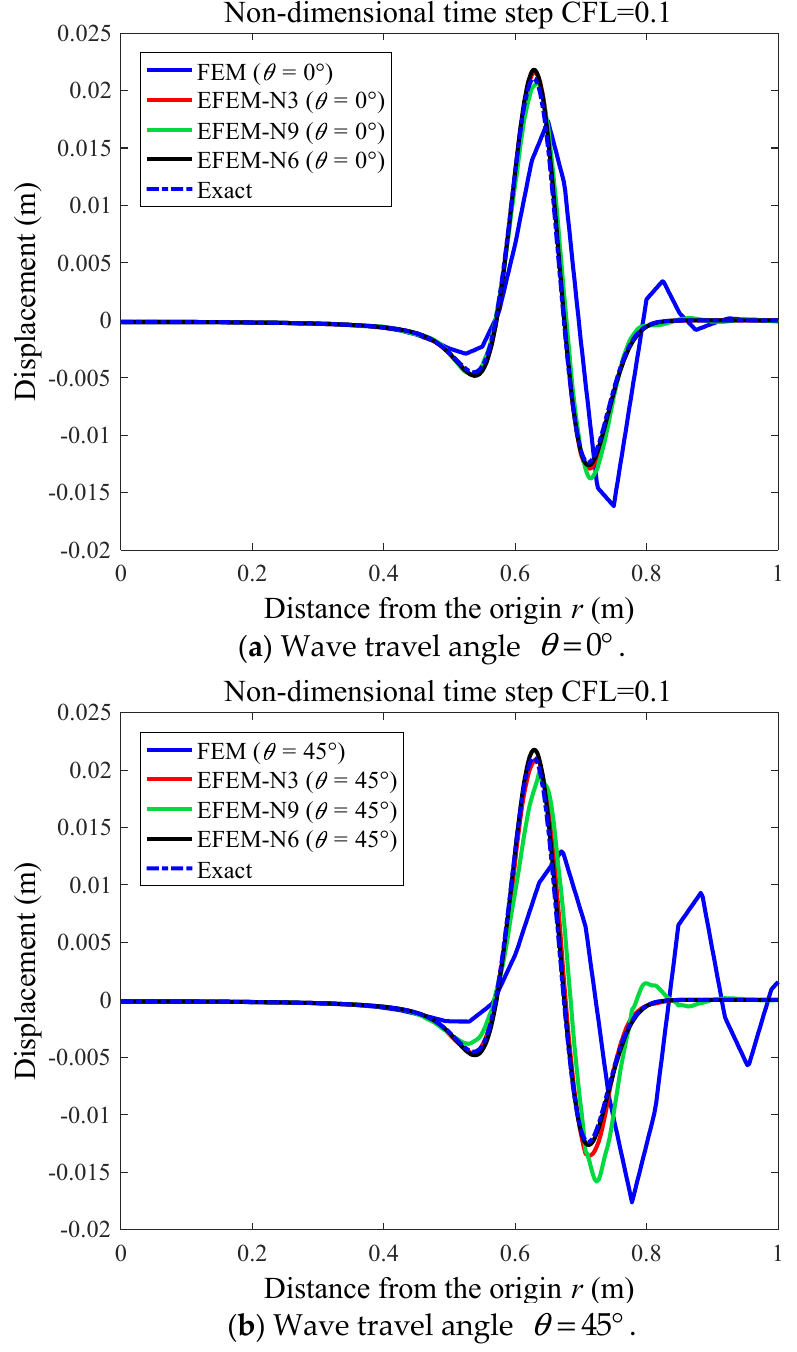
Figure 7. The displacement responses of the square membrane along two disparate angles of wave travel.